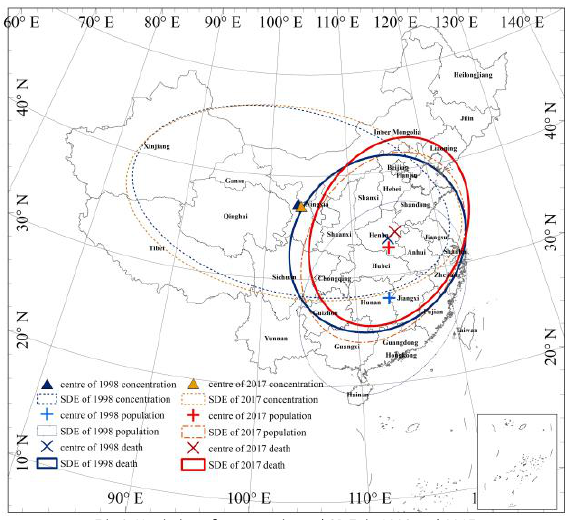
Fig.6. Variation of centre point and SDE in 1998 and